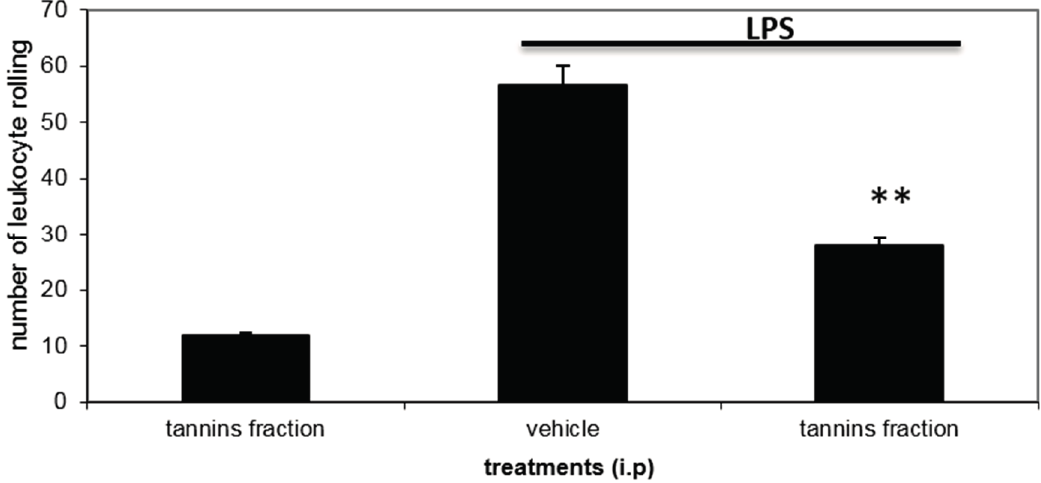
Figure 1. Effect of the tannins’ fraction from D. elliptica on leukocyte rolling number after lipopolysaccharides (LPS) topical application to the cremaster muscle in mice (intravital microscopy).Data are means ± S.E.M ( n = 11). ANOVA, followed by Dunnett’s test. ** p < 0.01 vs. the saline group within the same period of